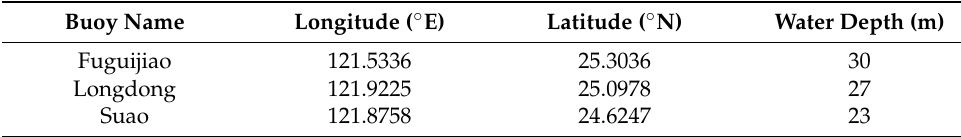
Table 1. Information on wave buoys. Buoy Name Longitude ( ◦